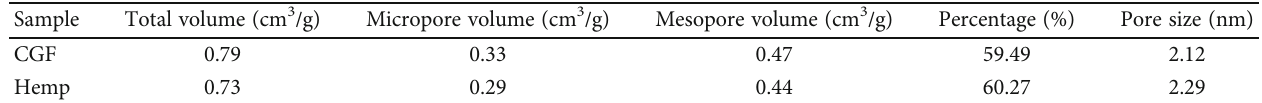
Figure 9: CGF and hemp-based bio composites under N Table 6: Pore diameter measurement of natural fi ber based on adsorbent characteristics.